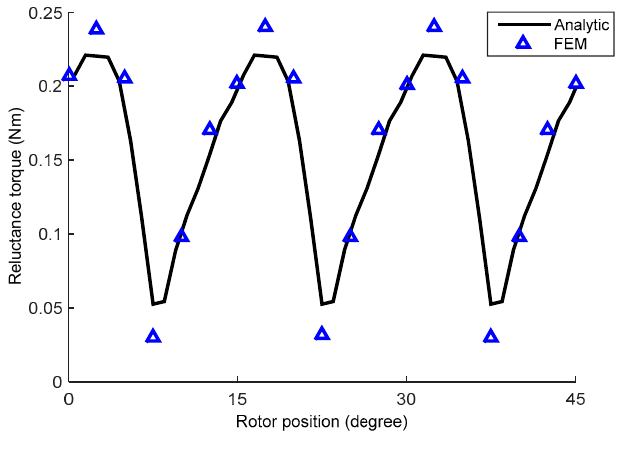
Figure 11. Reluctance torque vs. rotor position.